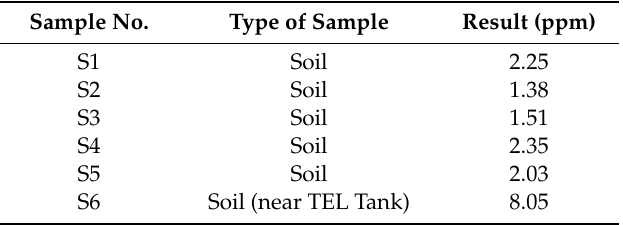
Table 12. Lead concentration of the Sulaymaniyah Oil Refinery soil samples. Sample No.